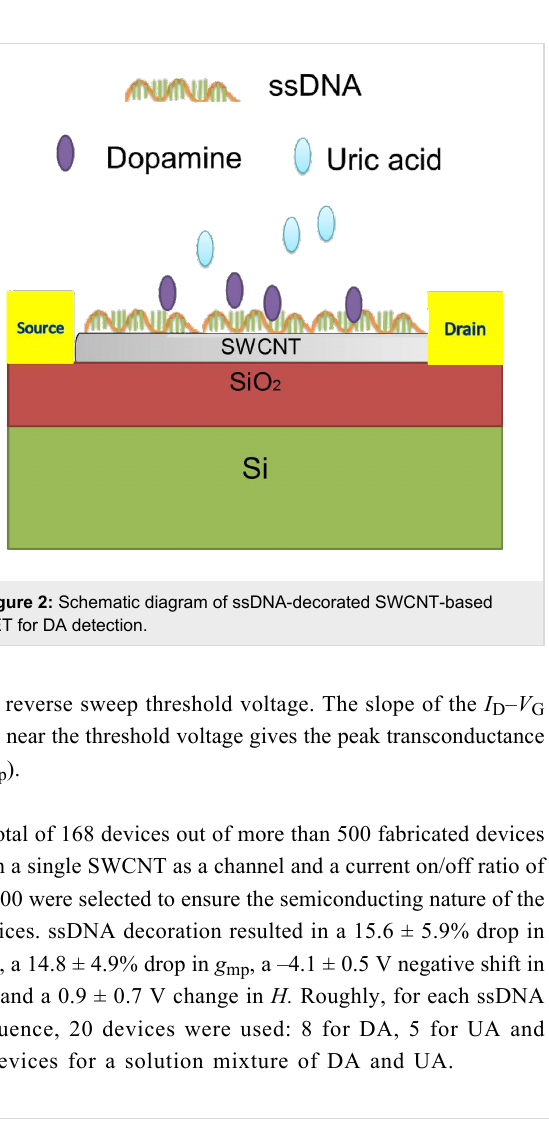
and reverse sweep threshold voltage. The slope of the I D –V G plot near the threshold voltage gives the peak transconductance ( g mp